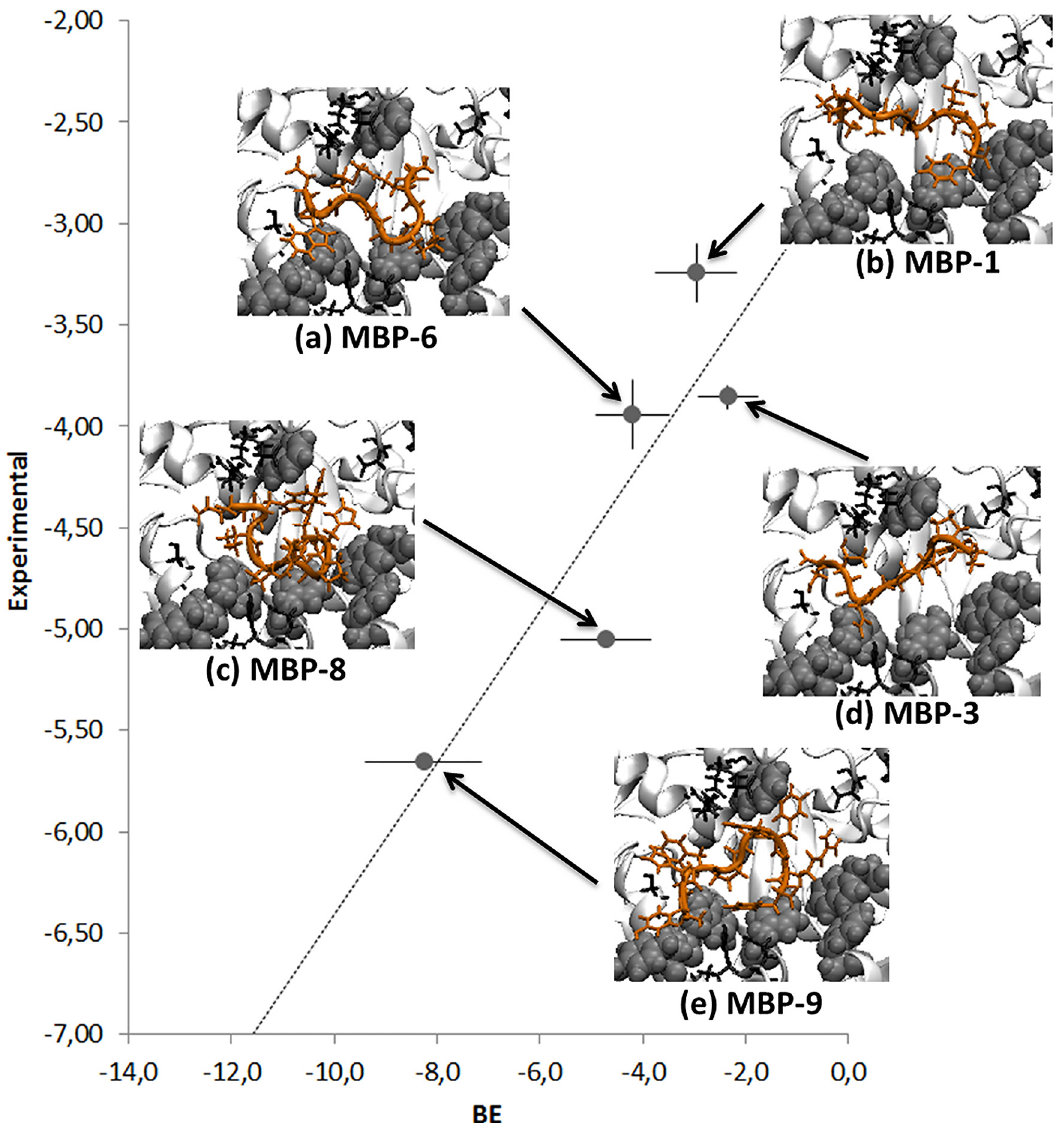
Fig 7. Comparison between the experimental binding and the MC+Vina calculated BE. The BE errorbars are standard errors of the means over 10 samples, while the experimental errobars are calculated as σ Δ G = 0.434( σ kD /k D ),. Docking into maltose site of peptides: (a) MBP-6, (b) MBP-1, (c) MBP-8, (d) MBP-3, (e) MBP-9. Highlighted with their Van der Waals spheres the MBP aromatic side chains involved in the binding (Tyr 155 219 34, Phe 337, Trp 62 340 230) and in black those capable of hydrogen bonding (Ser 337, Asp 14, Arg 66 344, Lys 297, Glu 153 44